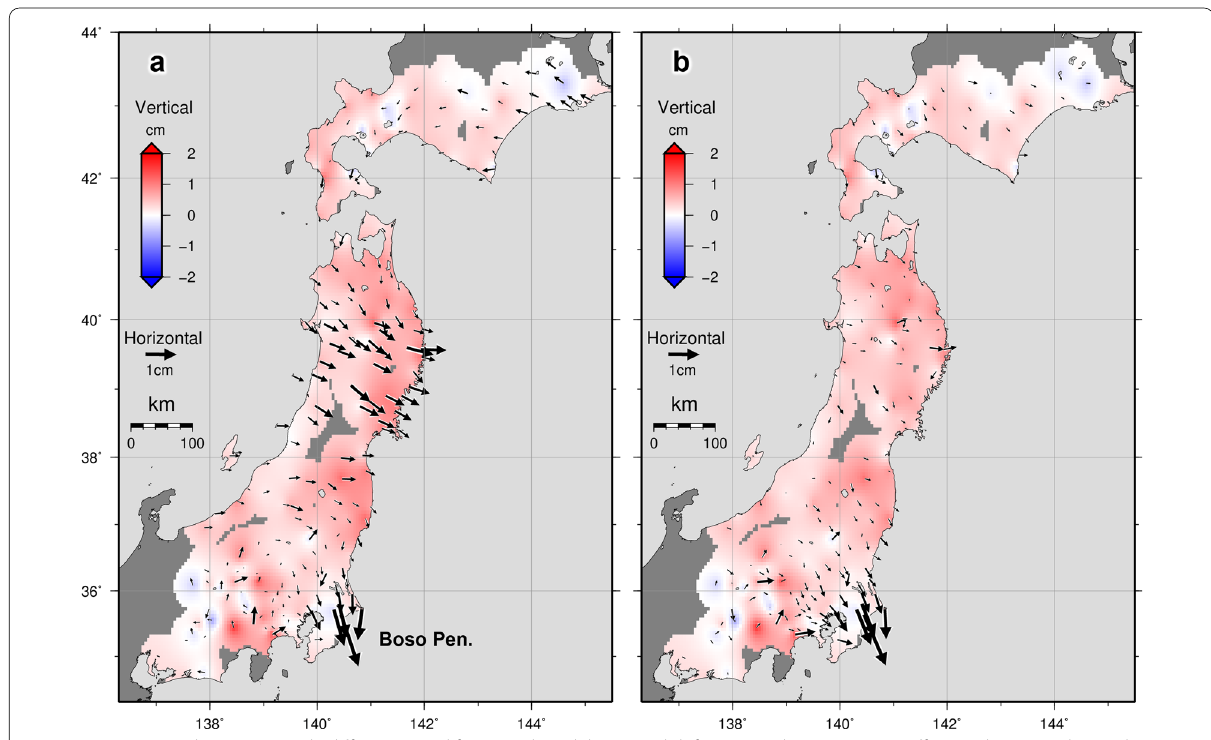
Fig. 14 Comparison between simple differences and functional model in crustal deformation discernment. a Difference between the 10-day averages of May 20–29 and June 26–July 5, 2018. b Subtracting the functional model of this study from